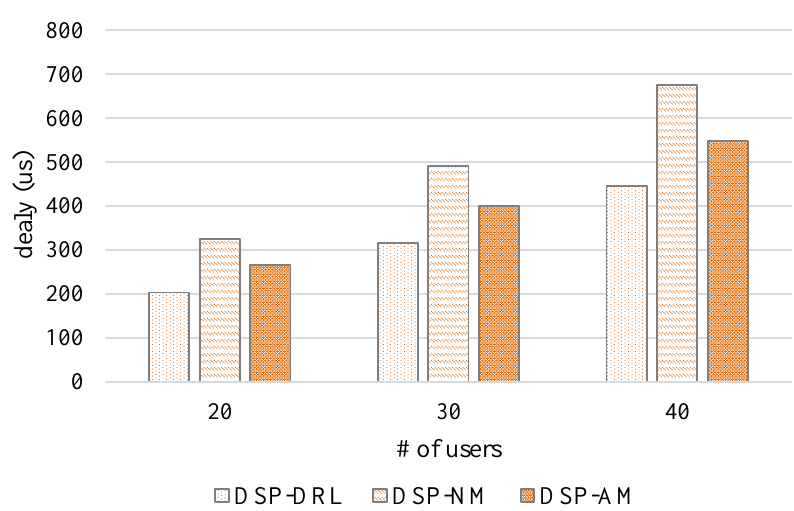
Figure 8. The average delay with 10 trajectories of each user group.